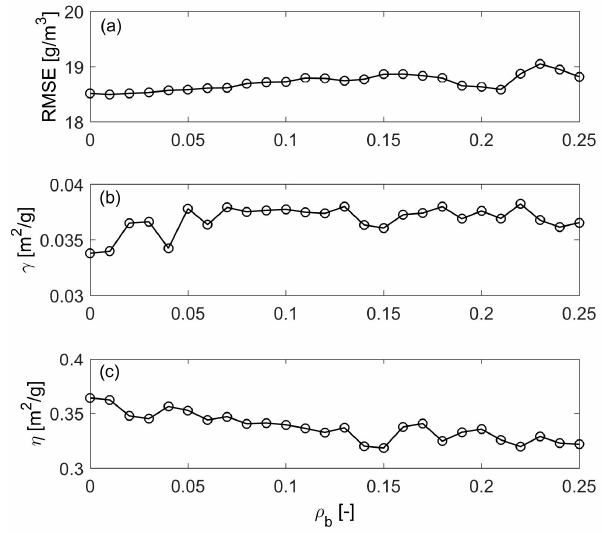
Figure 3. Sensitivity of the ( a ) root-mean-square-error (RMSE), and the suspended sediment specific ( b ) absorption ( γ ) and ( c ) backscattering ( η ) coefficients at around 400 nm to the input bottom reflectance ( ρ b ) values using all Hyperion bands.